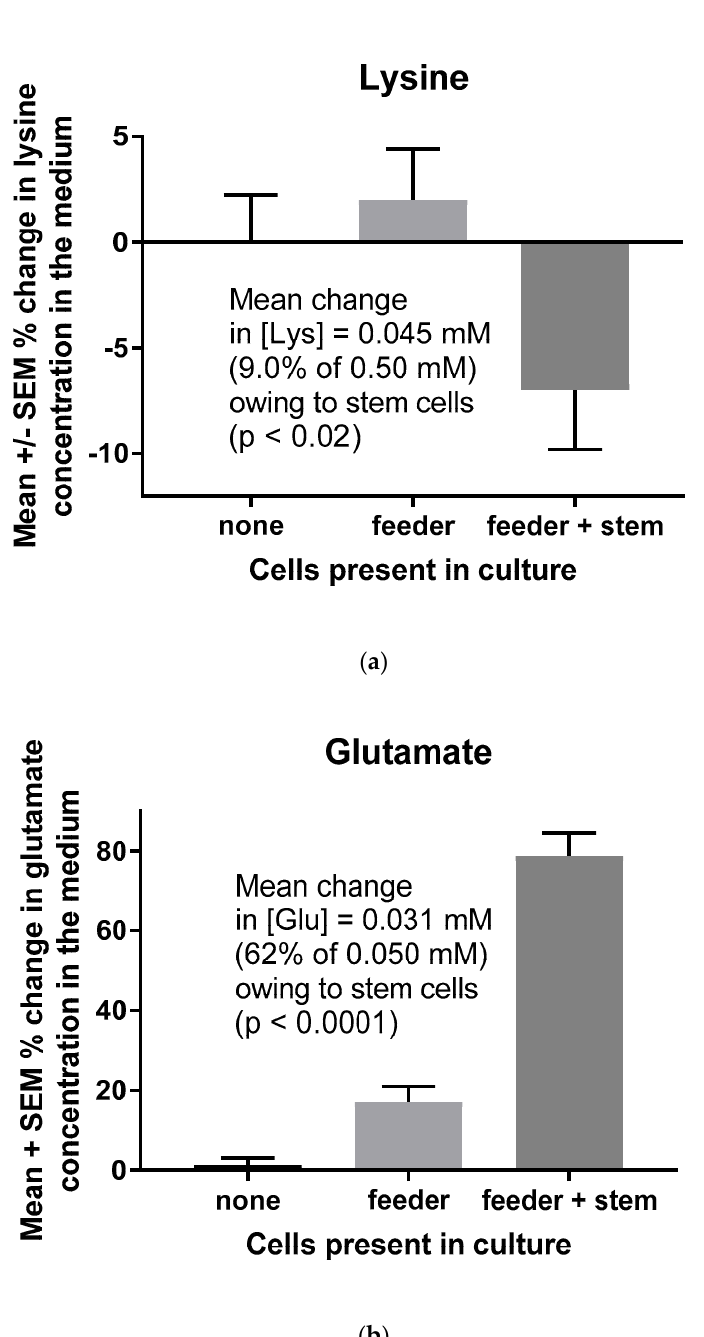
Figure 2. Lysine consumption ( a ) and glutamate production ( b ) by hES cells (H9 cell line, WA09). Cell-free control cultures were performed to show that, in the absence of cells, lysine and glutamate concentrations were unchanged in the medium. Lysine consumption and glutamate production were the differences between mean values in the presence of feeder cells vs. feeder plus stem cells ( n = 34 determinations of the lysine concentrations in the medium and n = 36 determinations of the glutamate concentrations in the medium). The p values are for t -tests between feeder cells vs. feeder plus stem cells, although the ANOVA of the three sets of data produced the same statistical conclusions for lysine consumption ( p < 0.05) and glutamate production ( p < 0.0001).